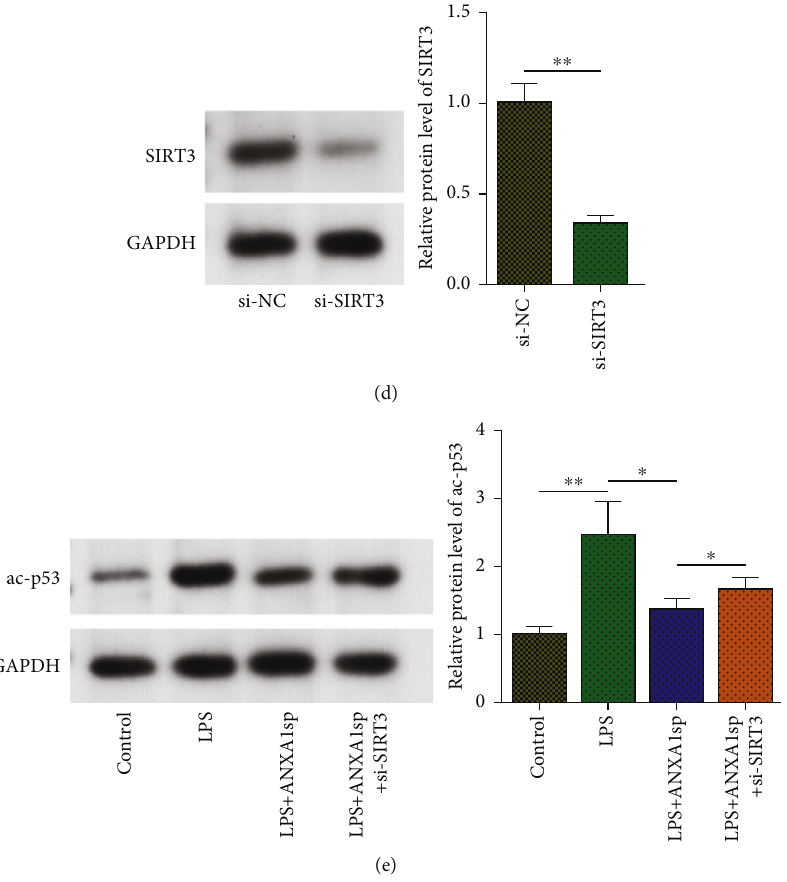
Figure 4: ANXA1sp promotes p53 deacetylation by enhancing SIRT3 expression. (a, b) WB for SIRT3, ac-p53, and p53 protein levels in H9C2 cells from control, LPS, or LPS+ANXA1sp groups. (c) Co-IP for interaction between SIRT3 and p53 in H9C2 cells from control or LPS groups. (d) Western blotting for H9C2 cells transfected with si-NC or si-SIRT3. (e) Western blotting for ac-p53 protein level in H9C2 cells from control, LPS, LPS+ANXA1sp, or LPS+ANXA1sp+si-SIRT3 groups. The experiments were repeated three times ( n = 3 ). Data were presented as mean ± SD . All statistical analyses were performed using Student ’ s t-test or one-way ANOVA. ∗ p < 0 : 05 ; ∗∗ p < 0 : 01 ; ∗∗∗ p < 0 : 001